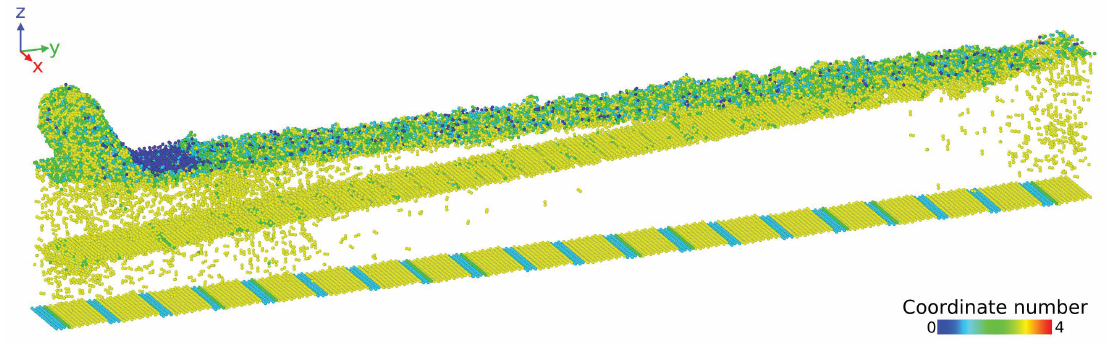
Figure 3. Coordinate number of the workpiece after